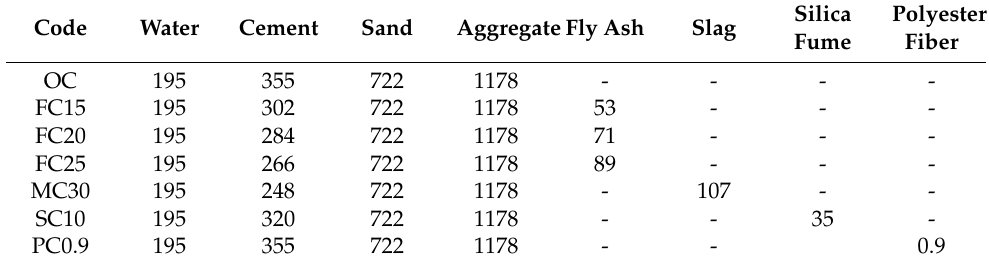
Table 5. Mix proportion of concrete (kg/m 3 ).